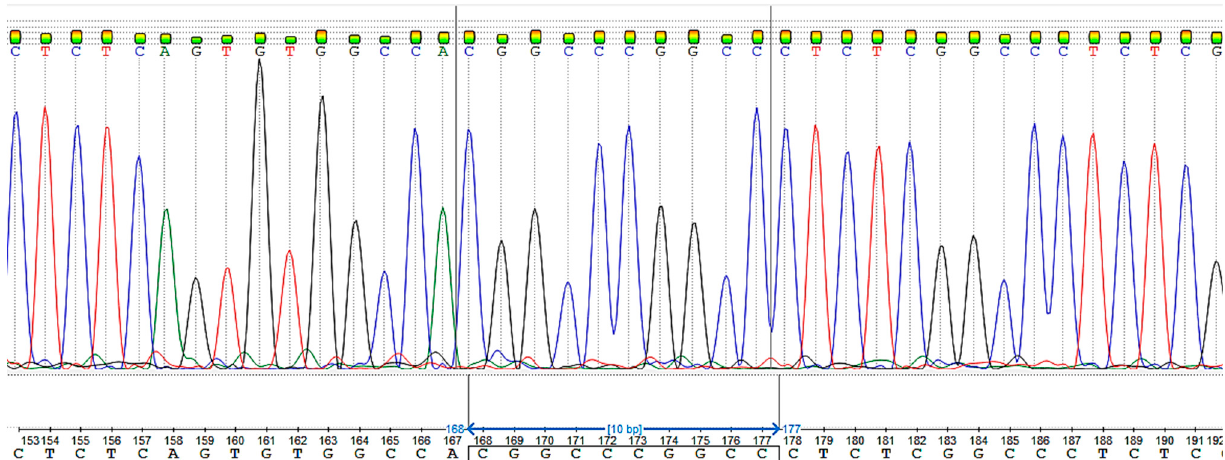
Figure 2. Patient Sanger sequencing. The duplication of five nucleotides–CGGCC.